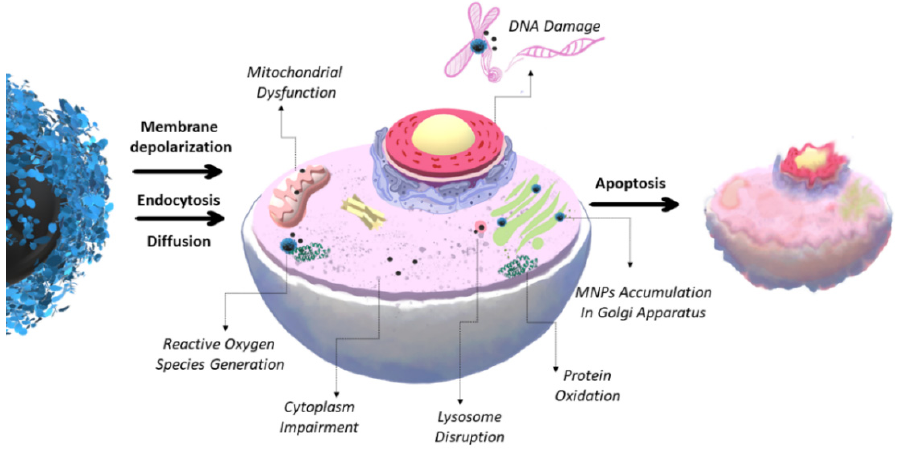
Figure 9. Possible toxicity mechanism of MNCs, leading cell processes’ dysregulation and triggering cell death (necrosis or apoptosis).